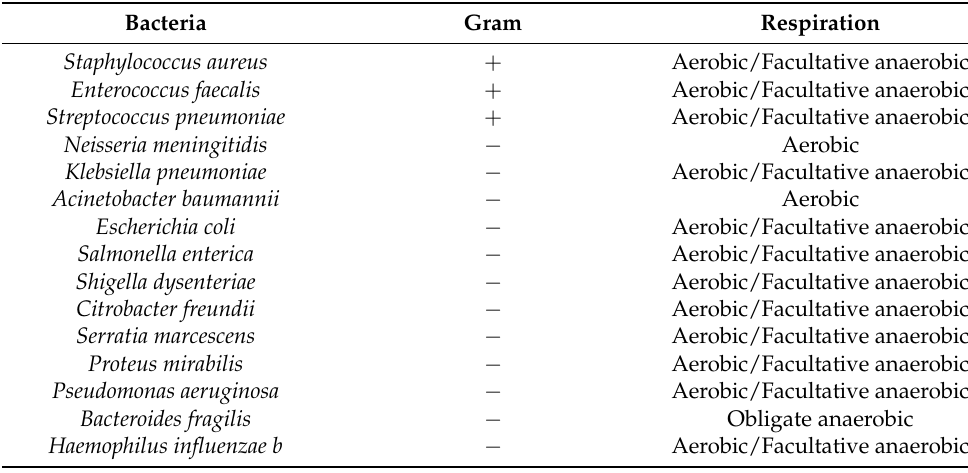
Table 1. List of main pathogenic bacteria than can cause sepsis